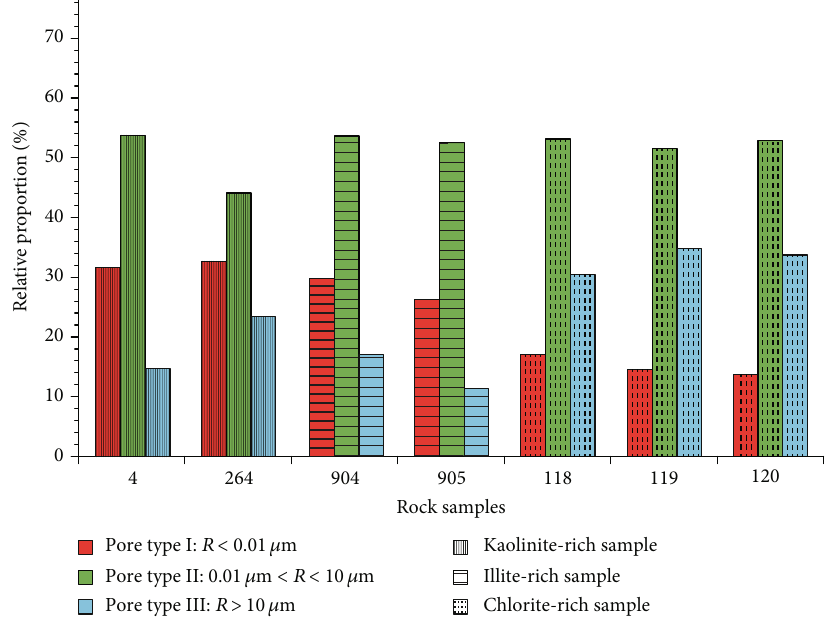
Figure 15: Comparison of di ff erent types of pore volume from di ff erent tight